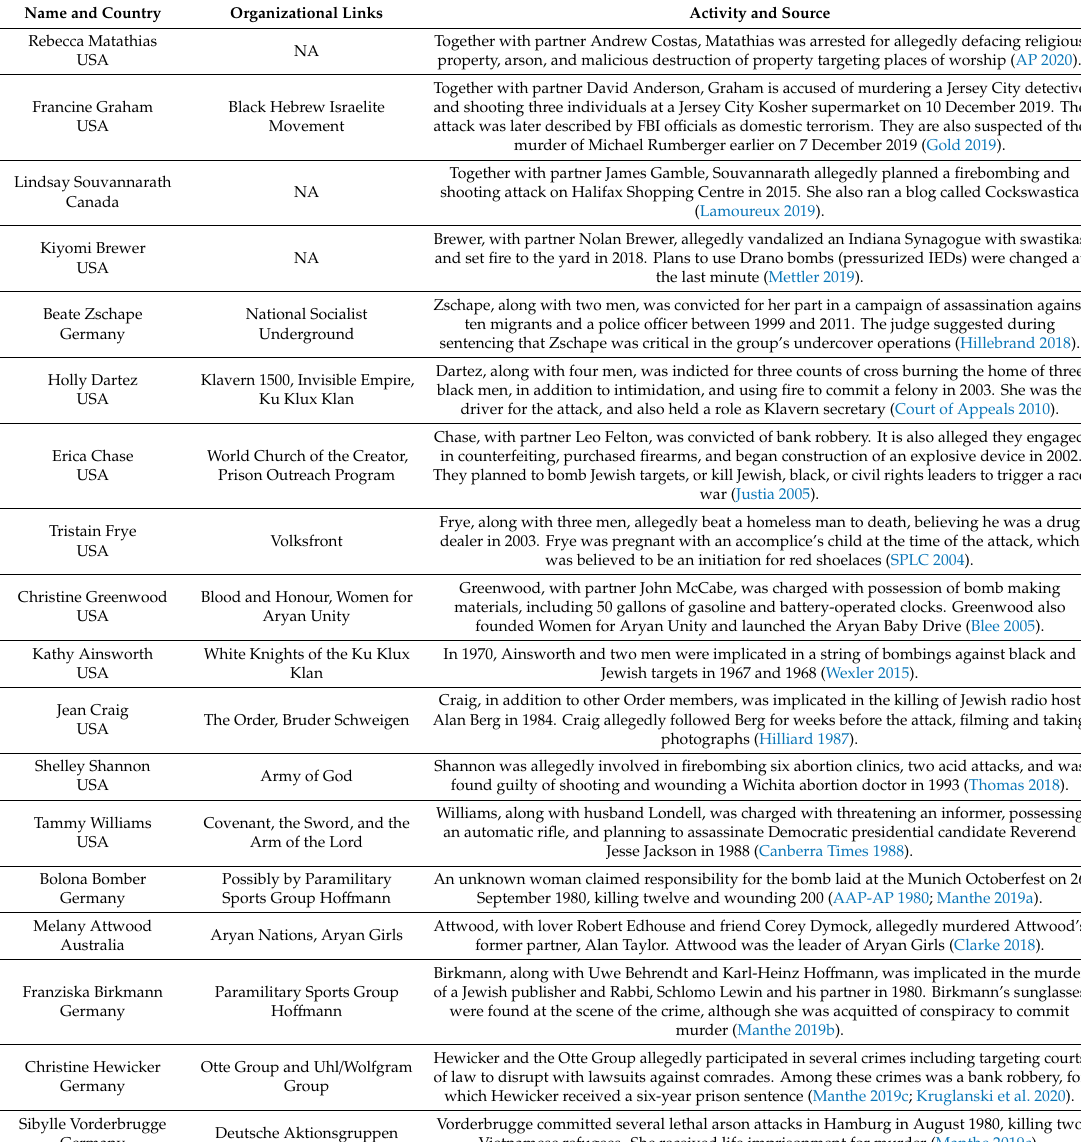
Table 1. Violent